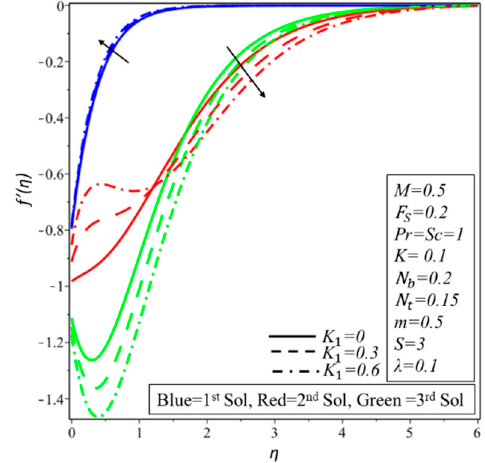
Figure 4. Profiles of the velocity for increasing values of K 1 .